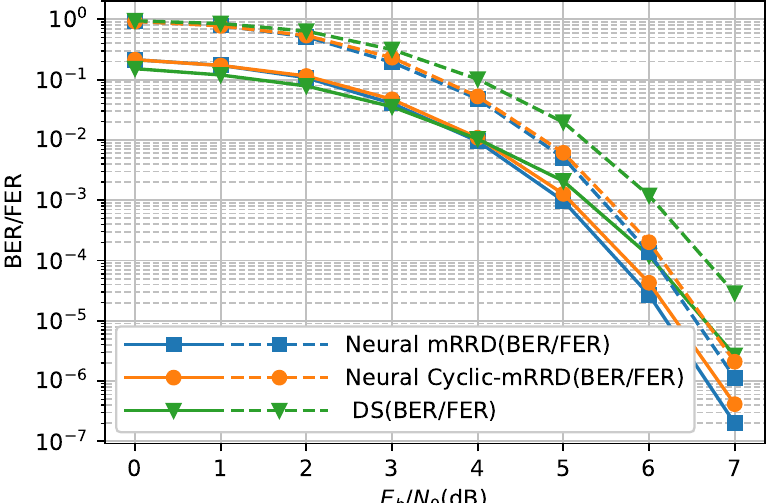
Figure 10. BER/FER performance of different decoders for the (73,37) QR